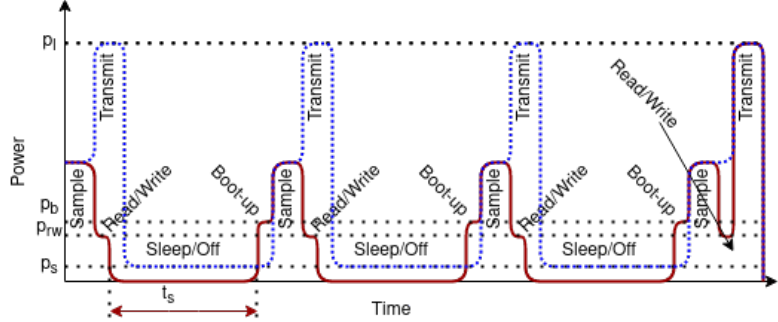
Figure 7. Energy savings by combining data and writing to persistent